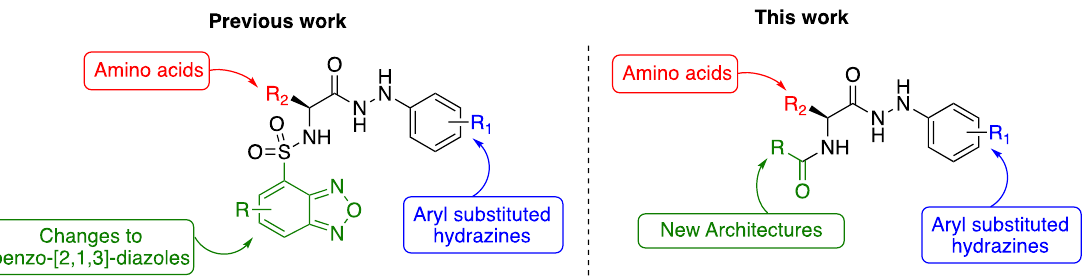
Figure 2. Inhibitors of M. tuberculosis based on a benzoxa-[2,1,3]-diazole framework, highlighting the